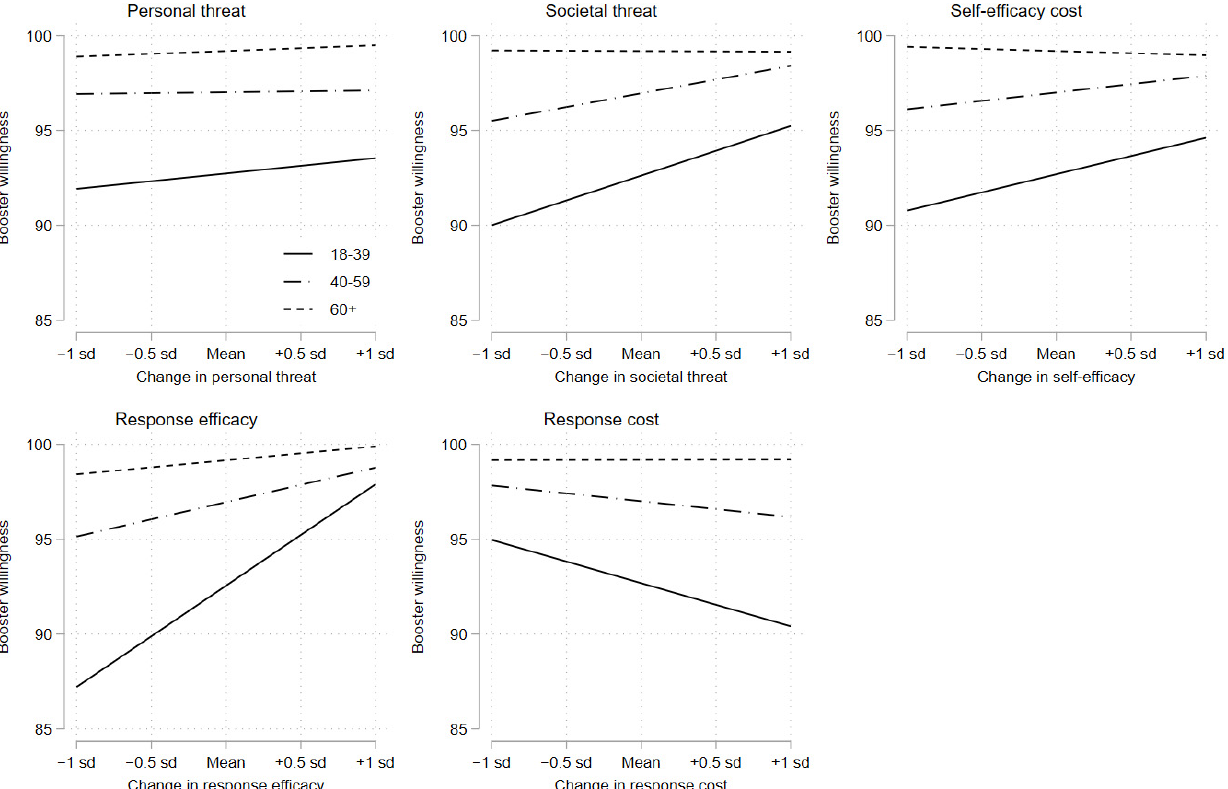
Figure 3. Associations between protection motivation and booster willingness by age. Note: Changes in the predicted willingness to take up boosters over personal threat, societal threat, self-efficacy, response efficacy, and response cost. Estimates are based on OLS regression. Solid lines are estimated probabilities for the young (18–39 years), dash-dotted lines for the medium-aged (40–59 years), and dashed lines for the old (60+ years).